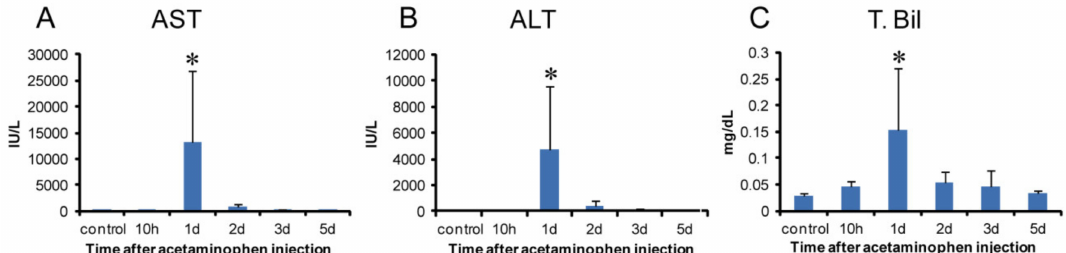
Figure 1. Biochemical analysis in APAP-induced rat hepatotoxicity. Samples were obtained at hour 10, days 1, 2, 3, and 5 after a single injection (1000 mg / kg body weight). The values of aspartate transaminase (AST) ( A ) alanine transaminase (ALT) ( B ) and total bilirubin (T. Bil) ( C ) transiently increased on day 1 with a significant change. Dunnett’s test; *, significantly di ff erent from controls at p < 0.05. Bar represents mean ± SD.